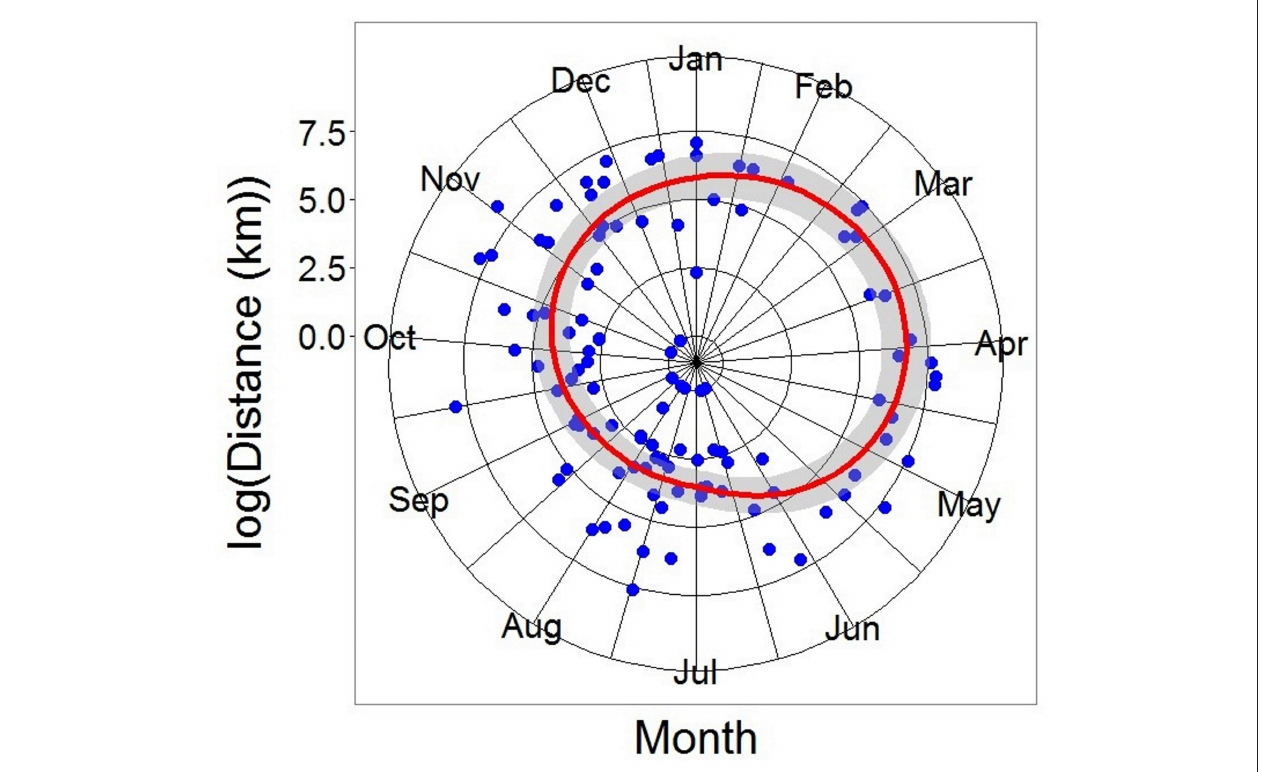
FIGURE 6 | Generalized Additive Model of all recaptured tope from the recapture. Distance modeled as a function of log (day of year of recapture). DF = 110, R 2 = 0.297, p < 0.05. Gray ribbon represents the Standard Error.